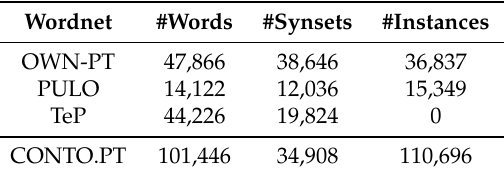
Table 3. Data of the wordnets